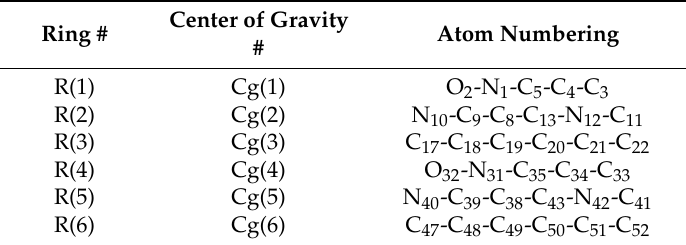
Table 3. Compact nomenclature for atomic rings (R) and their corresponding center of gravity (Cg) for the aromatic rings in 3 .